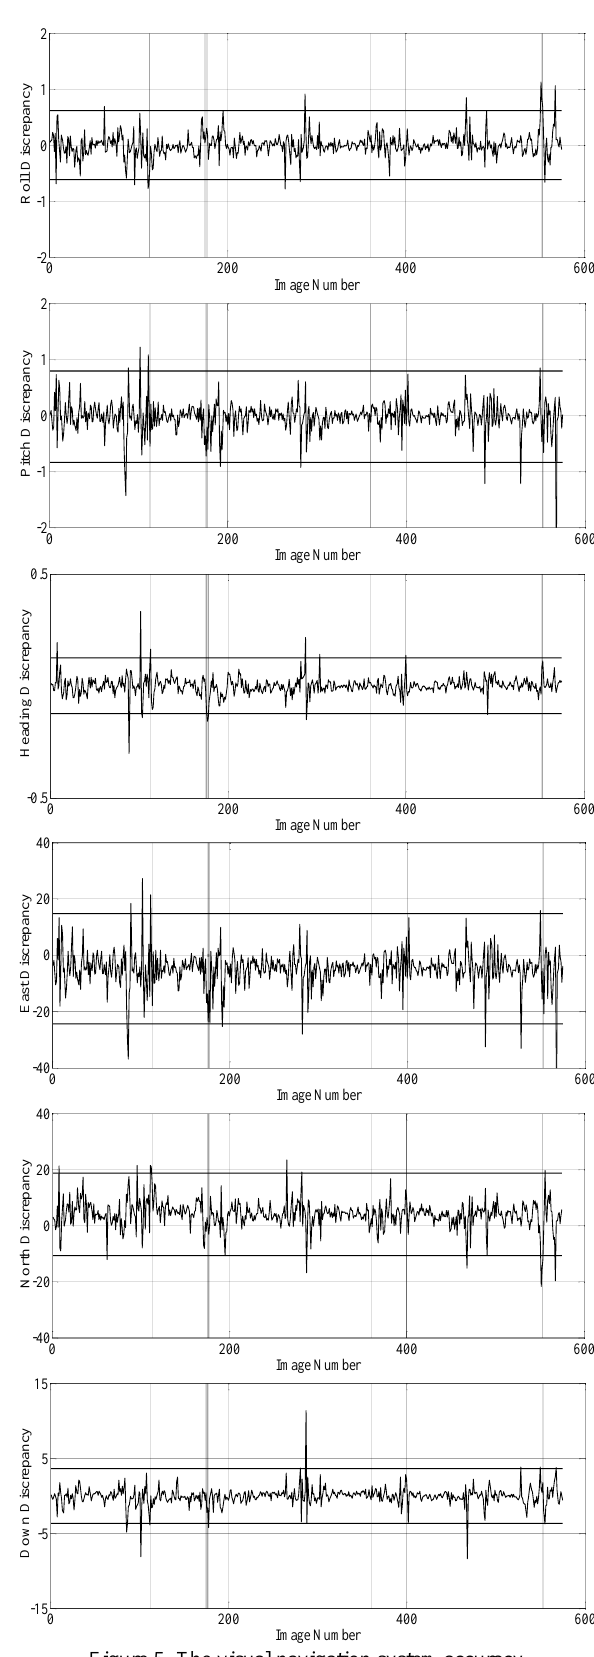
Figure 5. The visual navigation system